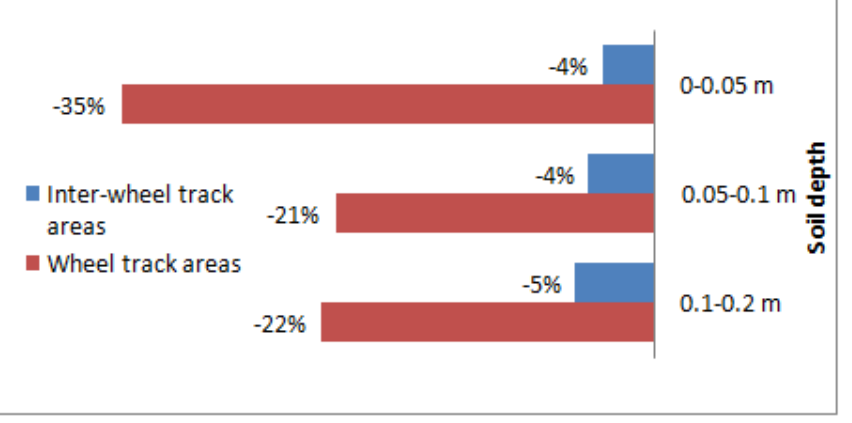
Figure 6: Relative variation (%) of Electrical Resistivity as a function of depth before and after tillage and machinery